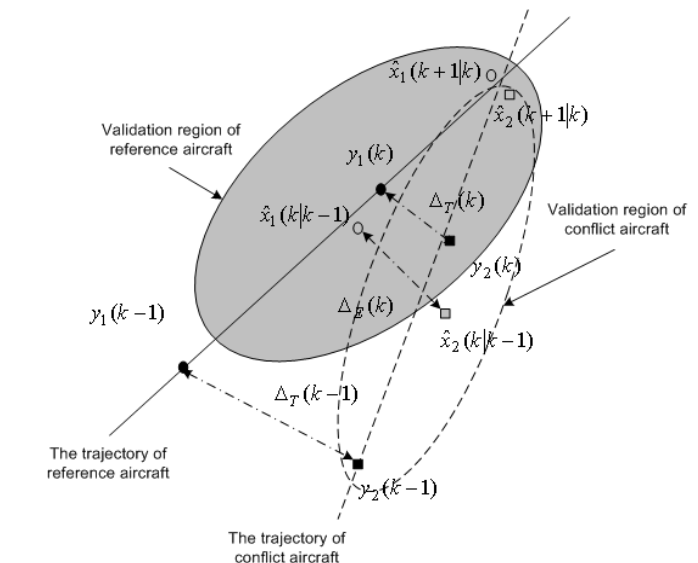
Figure 1 – Illustration of the PDAF with two measurements within the validation gate Рис . 1 – Иллюстрация фильтра для идентификации данных по вероятности (PDAF) с двумя измерениями внутри подтвержденного окна Слика 1 – Илустрација филтра за придруживање података по вероватноћи (PDAF) са два мерења унутар потврђеног